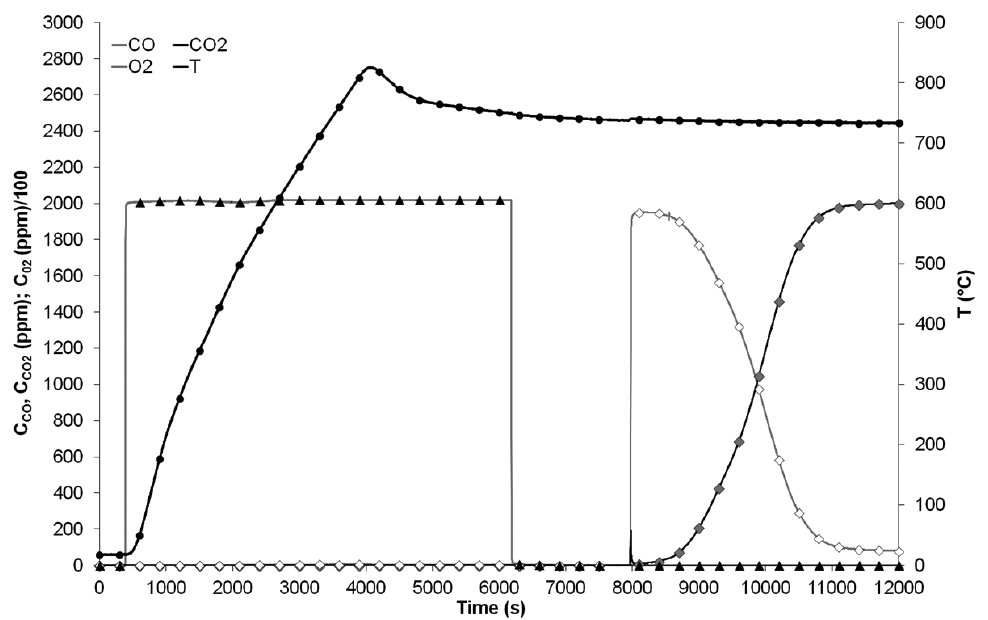
Figure 3. First oxidation-reduction cycle (after activation cycle) of 0.28 g of NiO/NiAl procedure